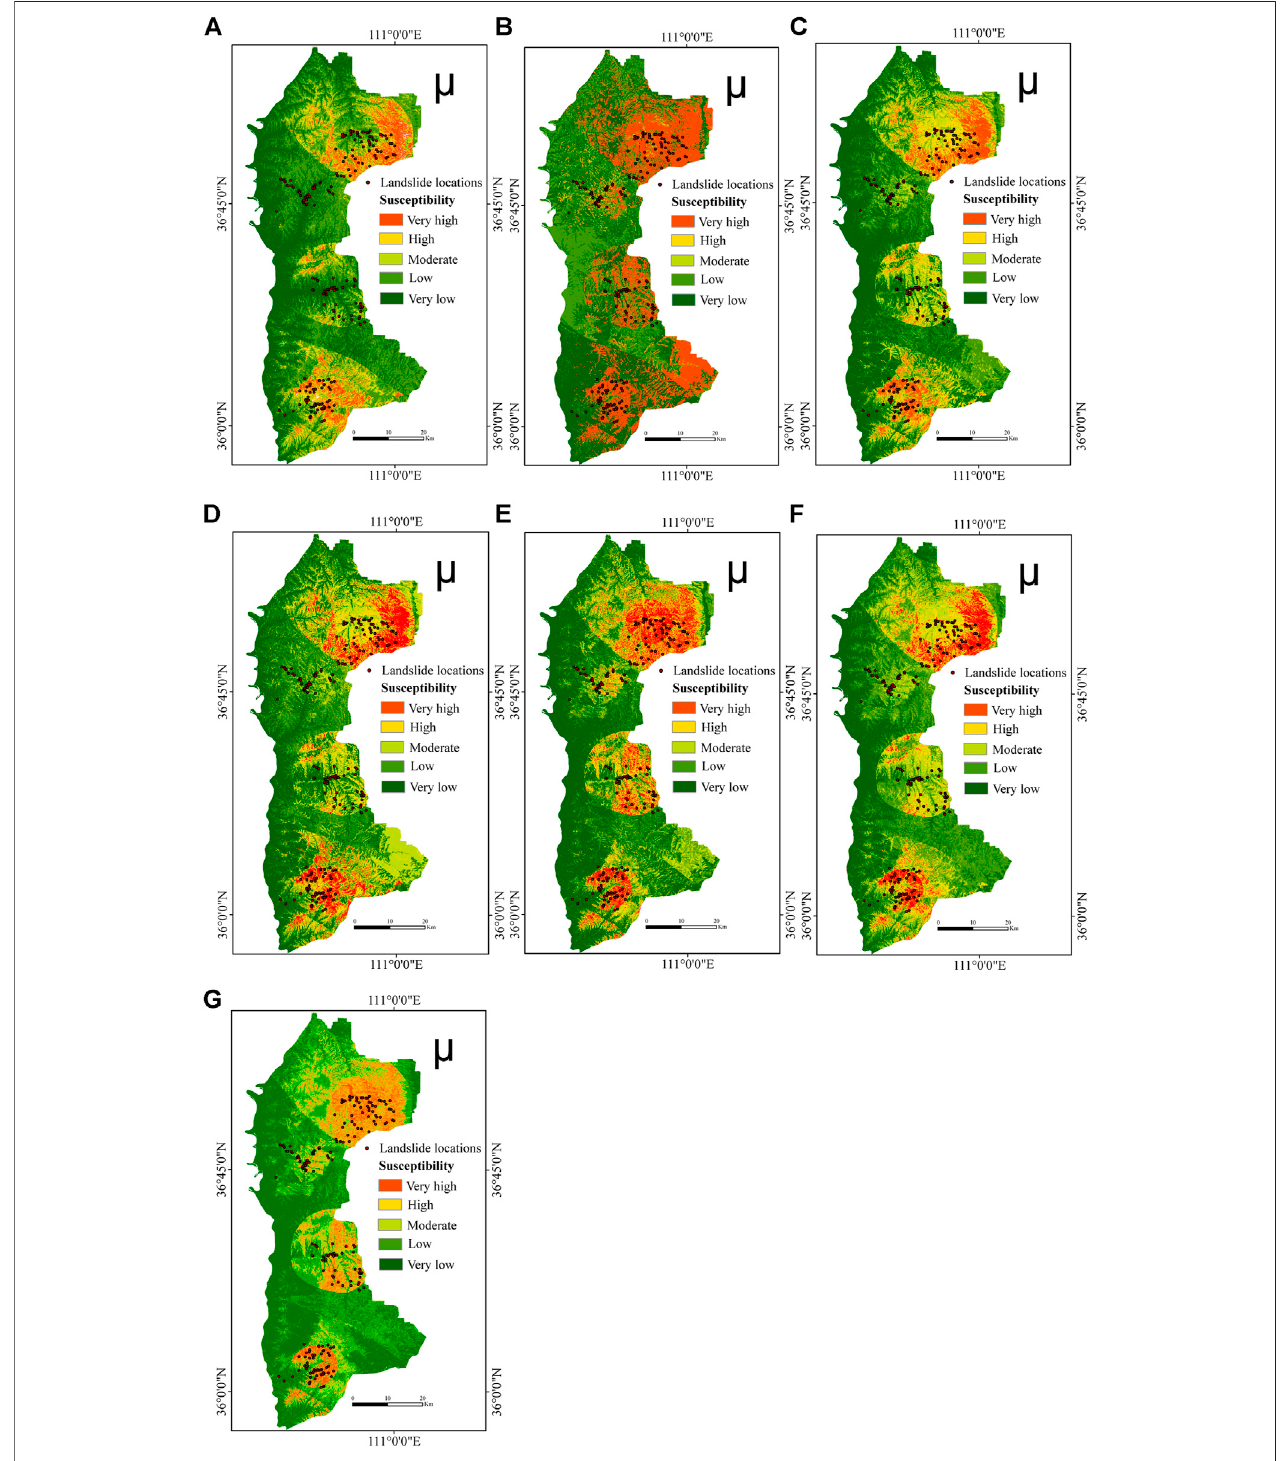
FIGURE 6 | Landslide susceptibility maps respectively produced by different models: (A) BP, (B) SVM, (C) RF, (D) BP-SVM, (E) BP-RF, (F) SVM-RF, and (G) integrated BP-SVM-RF.